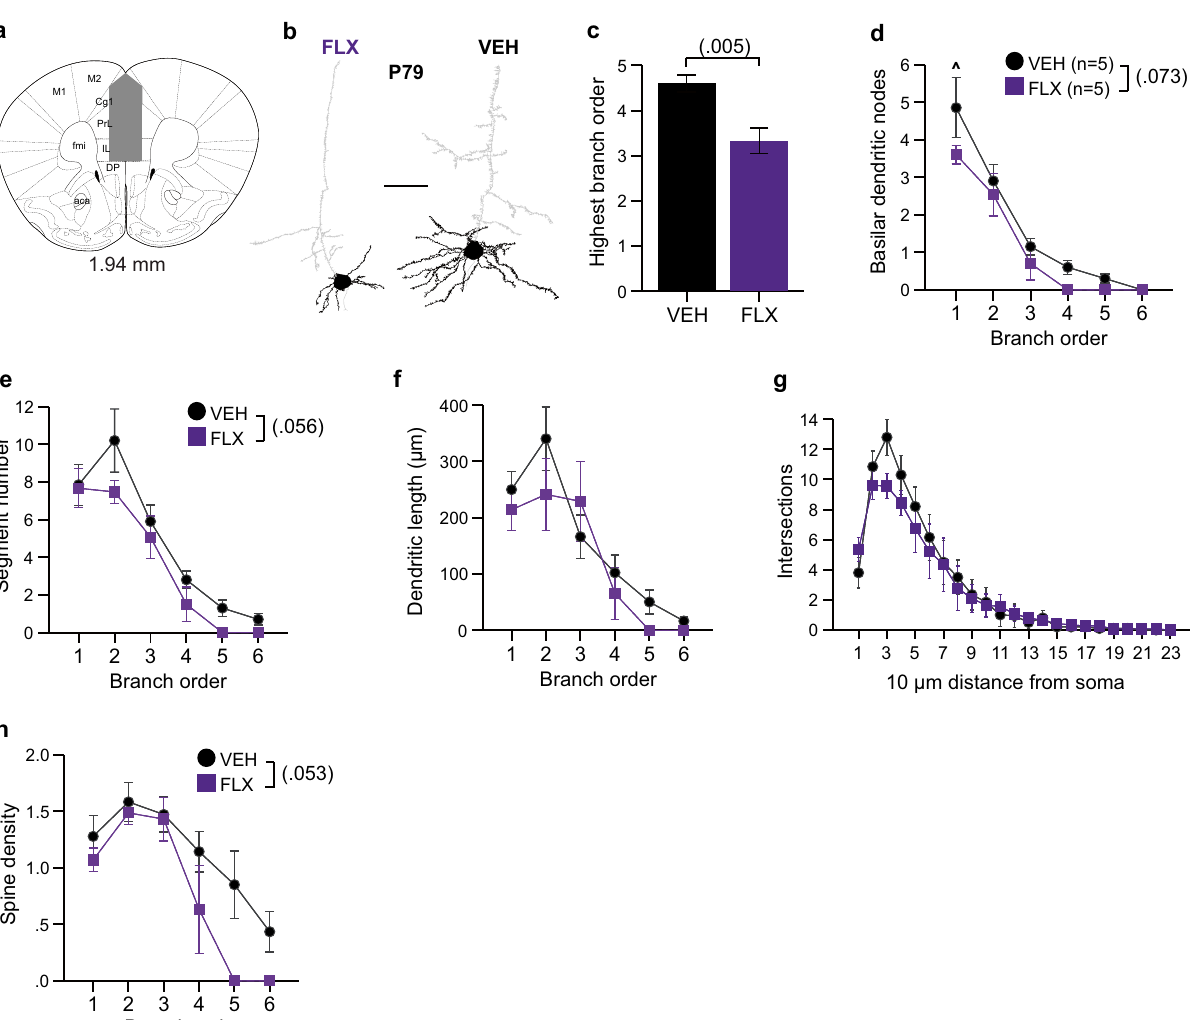
Figure 3. Maternal FLX results in decreased dendritic branching complexity and spine density in adult mice in mPFC layer V pyramidal neurons. ( a ) mPFC area used for neuron selection marked in grey; adapted from Franklin and Paxinos, 2008 48 . Number indicates distance from bregma. ( b ) Representative tracings of Golgi- Cox impregnated mPFC layer V neurons from P79 FLX and VEH brains. Areas in black indicate quantified basilar dendrites and soma. Scale bar is 50 µm. ( c ) P79 FLX-exposed layer V neurons failed to reach the same extent of basilar dendritic branching as VEH-exposed neurons. (n = 10 neurons averaged from 5 VEH mice and n = 10 neurons averaged from 5 FLX mice). ( d-e ) Number of basilar branching nodes and dendritic segments per basilar dendritic branch order were non-significantly reduced in FLX-exposed neurons compared to VEH-exposed neurons at P79. ( f-g ) FLX exposure failed to impact basilar dendritic length per branch order or number of intersections per 10 µm distance from the soma in P79 mPFC neurons. ( h ) Spine density per basilar dendritic branch order was non-significantly reduced at P79. Data are means ±